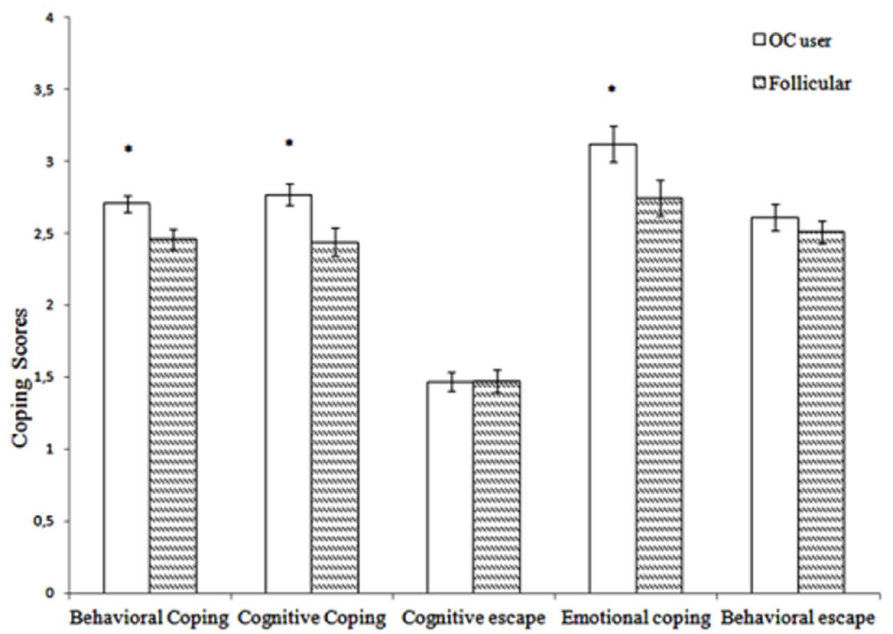
Fig. 3. Mean values ¡ SEM of the five second-order factors of the COPE questionnaire that represents active coping (Behavioral coping, Cognitive coping, and Emotional coping) and passive coping (Cognitive escape and Behavioral escape) (* p ,